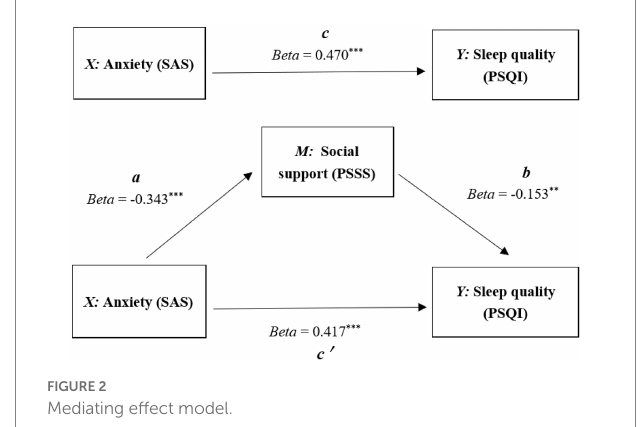
FIGURE 2 Mediating effect model.